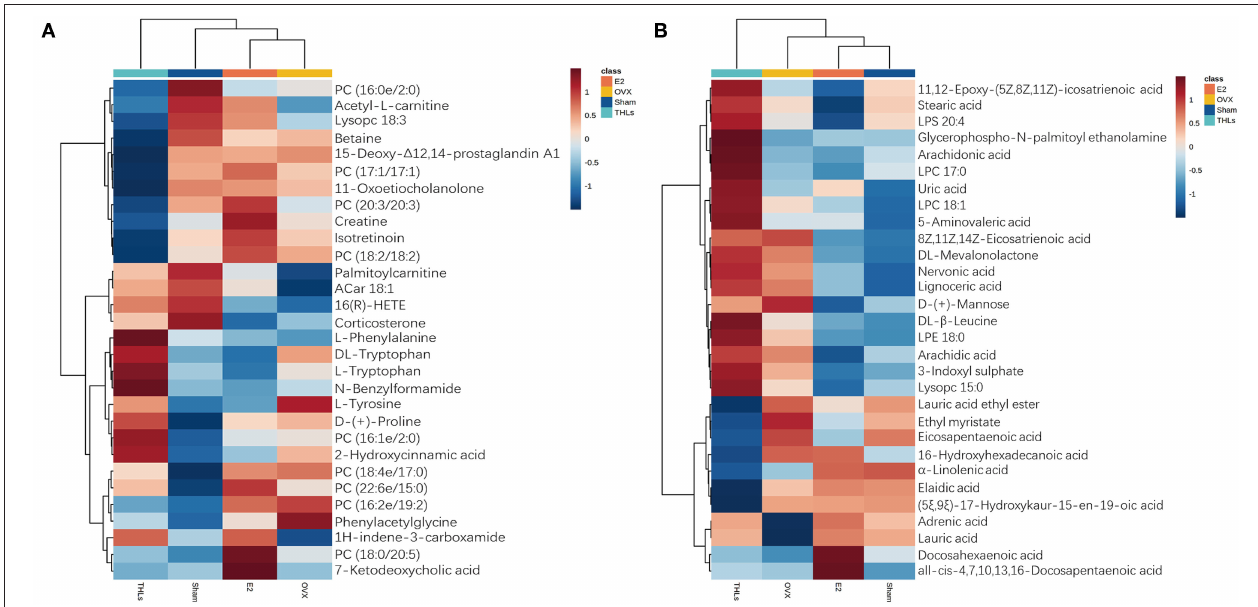
FIGURE 6 | HCA for differential metabolites of top 20. (A) Positive ion model. (B) Negative ion model. Vertical is the clustering of samples, and horizontal is the clustering of metabolites. The shorter the cluster branches, the higher the similarity. The clustering relationship of metabolite content between groups can be seen via horizontal